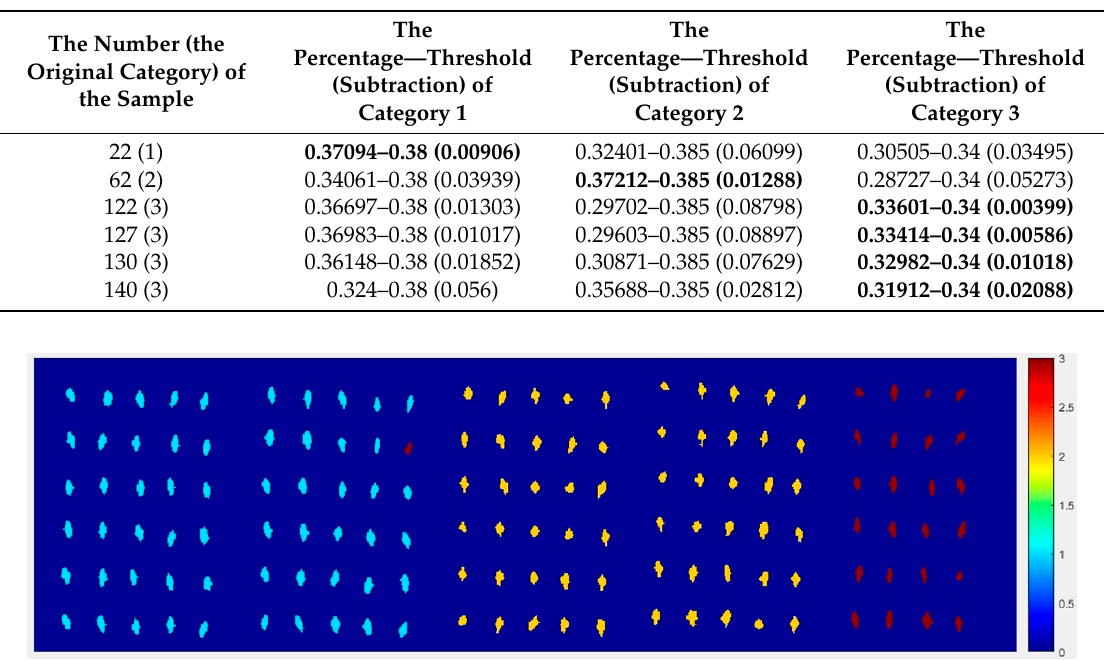
Table 6. The percentage and subtraction of each uncertain Jindan10 corn seed sample.